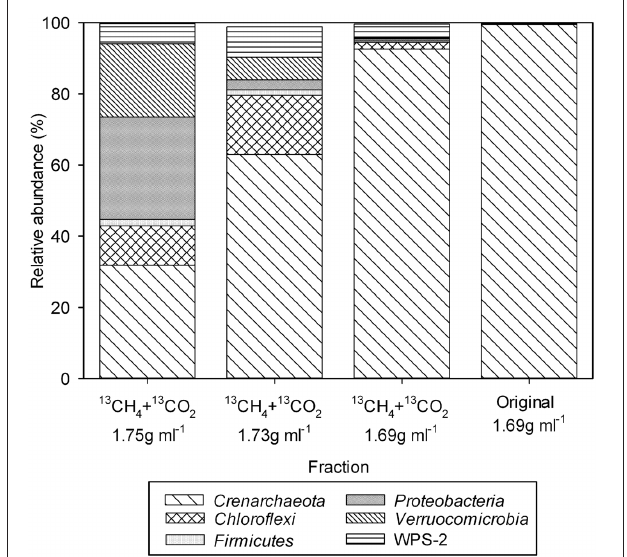
FIGURE 3 | Relative abundance of different bacterial and archaeal phyla from heavy DNA (density 1.73g ml − 1 and 1.75g ml − 1 ) and light DNA (density 1.69g ml − 1 ) from the TIK5 13 CH 4 + 13 CO 2 SIP experiment, and the control soil (density 1.69g ml − 1 ). 16S rRNA gene sequences were clustered based on 97% identity and classified via BLAST (Altschul et al., 1990) based on the Greengenesdatabase of bacterial and archaeal 16S rRNA gene amplicons (Desantis et al.,